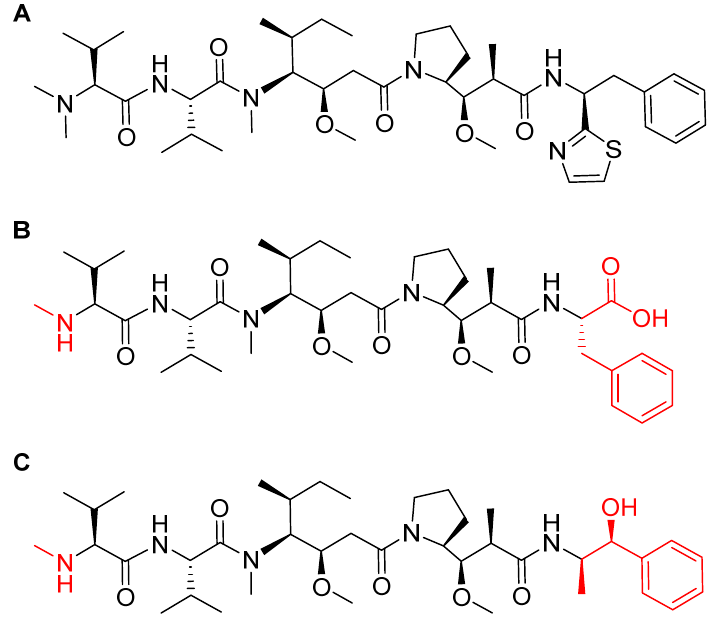
Figure 8. Chemical structure of: ( A ) natural dolastatin 10; ( B ) monomethyl auristatin F (MMAF); and ( C ) monomethyl auristatin E (MMAE). Differences from the natural molecule are shown in red [44].